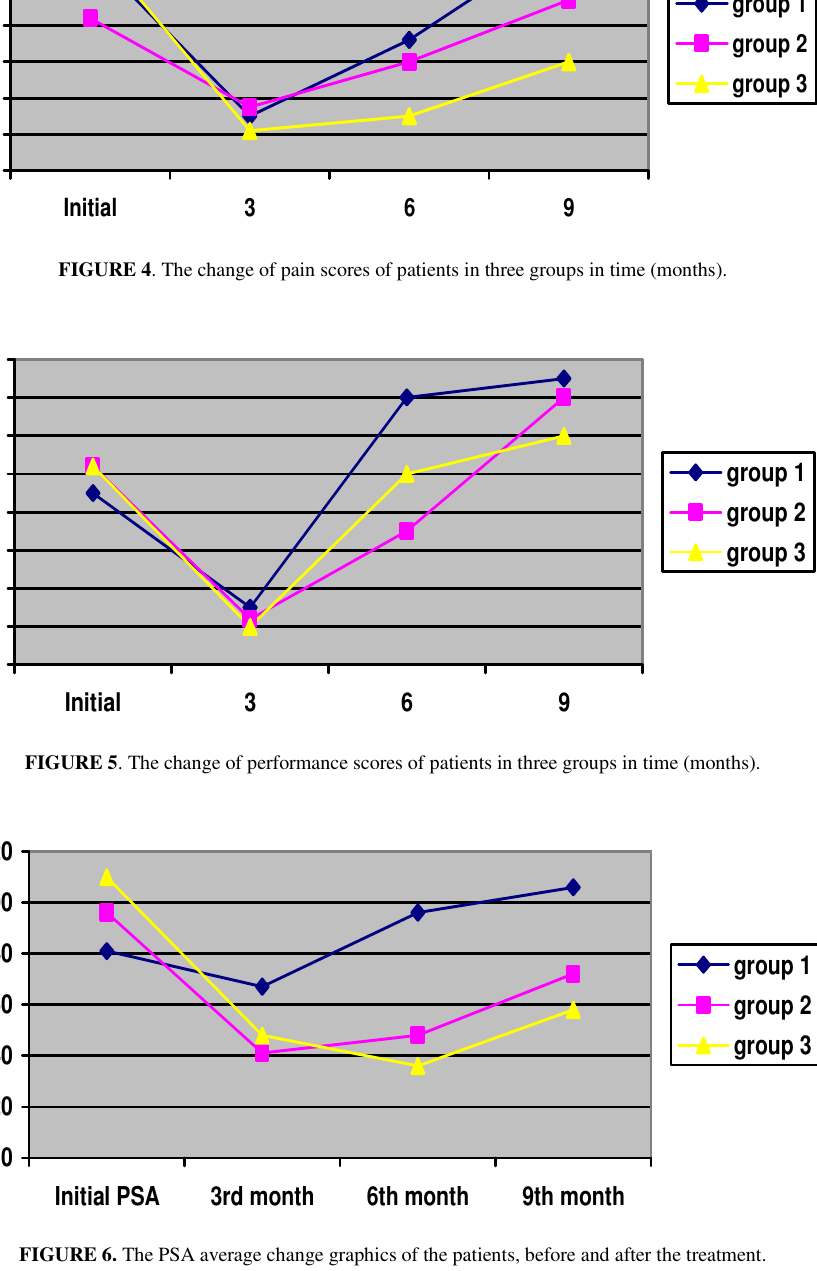
FIGURE 6. The PSA average change graphics of the patients, before and after the